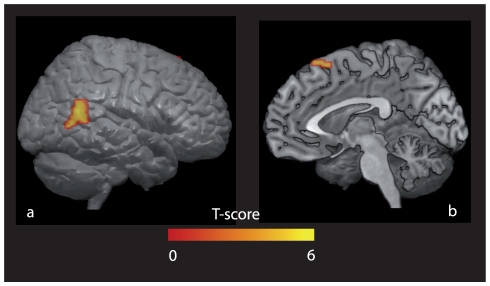
Brain correlates of communication via pointing.Brain areas showing greater activation for communicative (CP) versus non-communicative (NCP) pointing are plotted onto 3D render MNI templates. a) right posterior STS at the temporo-parietal junction (lateral view, right hemisphere), b) right pre-SMA (medial view, right hemisphere) (FDR corrected, p<0.05).